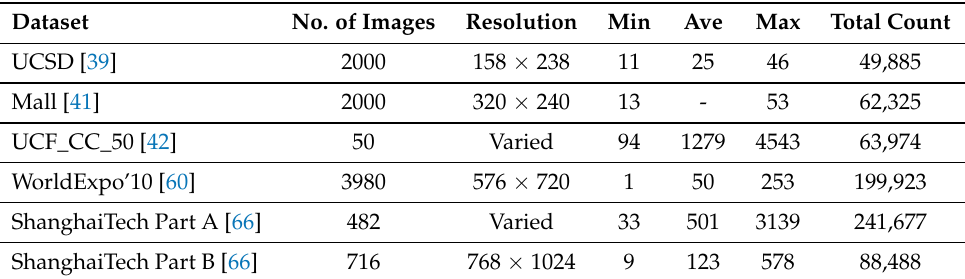
Table 3. Datasets